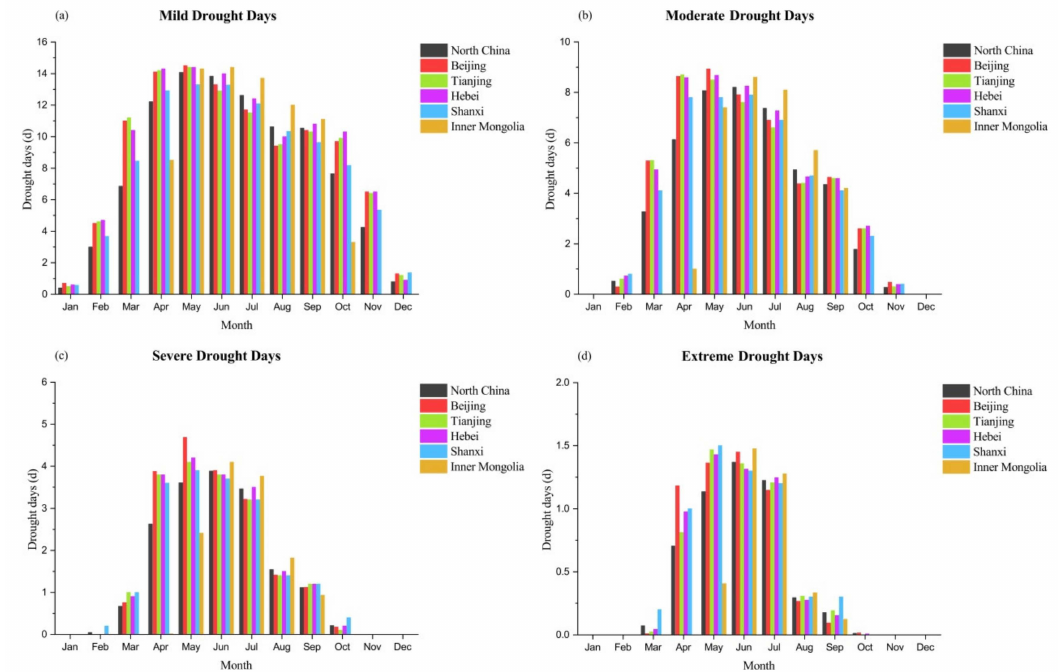
Figure 5. Characteristics of monthly changes from mild drought ( a ), moderate drought ( b ), heavy drought ( c ) and extreme drought ( d ) in North China from 1960 to